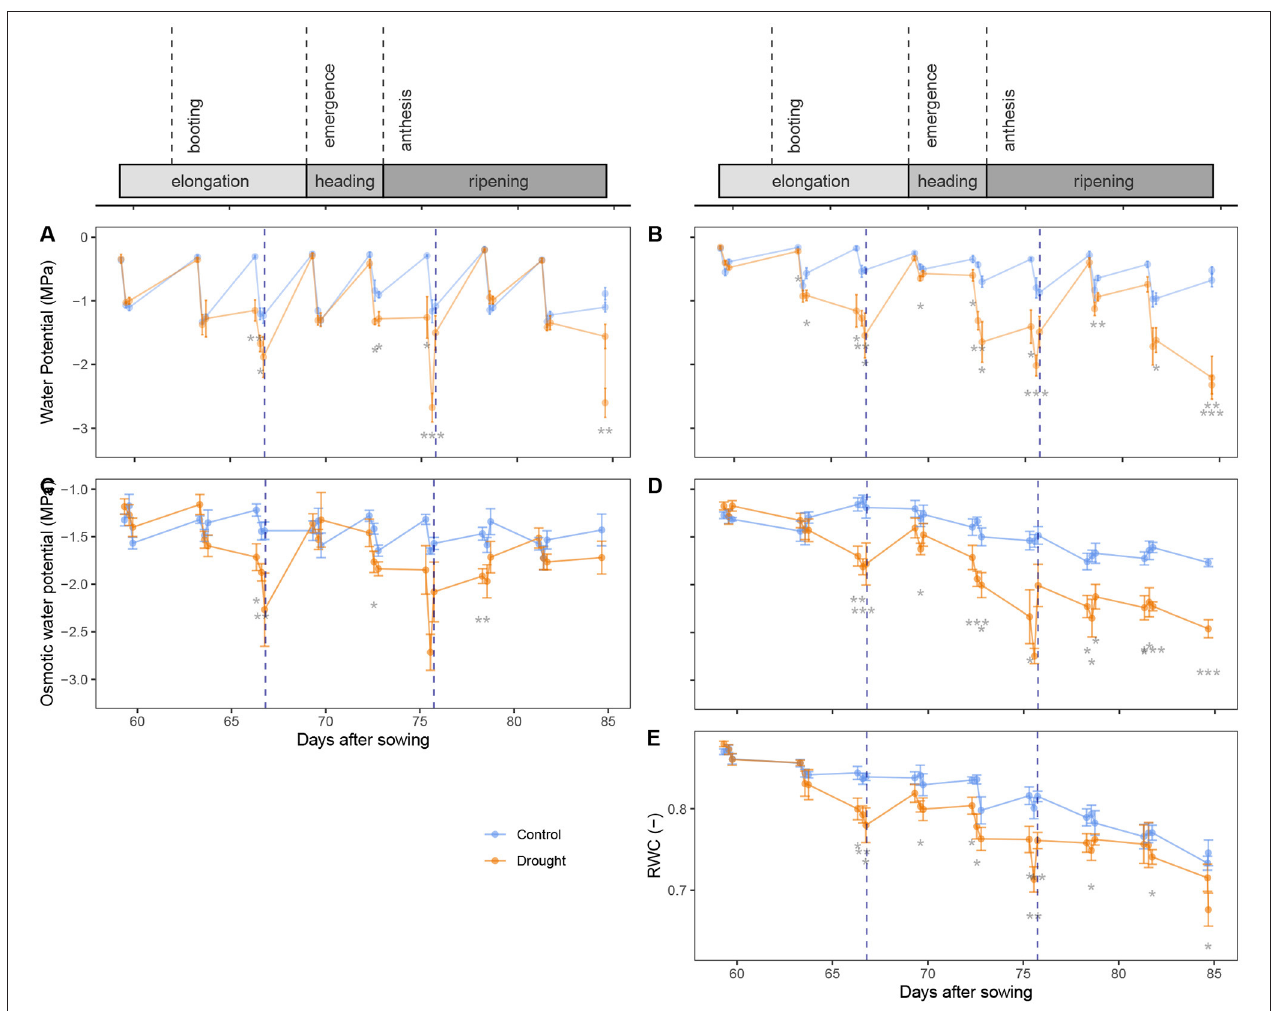
FIGURE 2 | Development of different physiological variables in time, expressed as “days after sowing” (DAS): xylem water potential in the flag leaf (A) and bottom leaf (B) , osmotic potential in the flag leaf (C) and in the stem (D) and water content in the stem (E) . Above the graphs, different phenological periods or events are visualized on the same timeline as the data. Rewatering events are marked with a blue dotted line. The control and drought treatment are depicted in blue and orange, respectively. Every 3 days, these variables were measured at predawn, midday and afternoon. Mean ( n = 5) and standard error are depicted and the means are connected with lines to improve the visibility of the trends. Significant differences between the control and drought treatment are indicated below the measurements. Significance levels: * p < 0.05, ** p < 0.01, and *** p < 0.001.